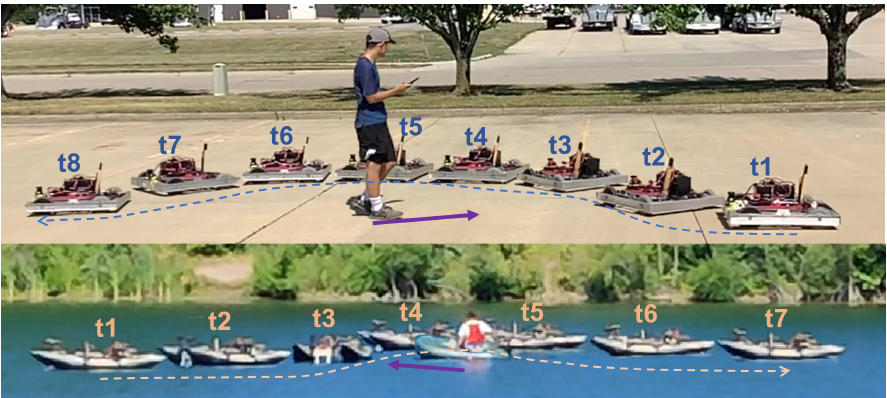
Figure 1. Motion lapse images of a UGV and a USV avoiding a dynamic obstacle using the same trained DRL agent. The trajectories of the vehicles are shown as dashed lines. The direction of the instantaneous velocity of the obstacles is shown as purple